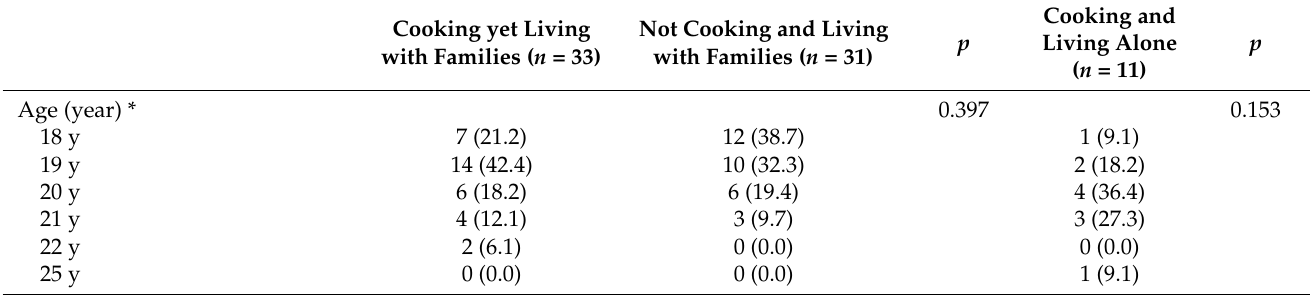
Table 2. Association of sociodemographic characteristics with cooking among female university students ( n =